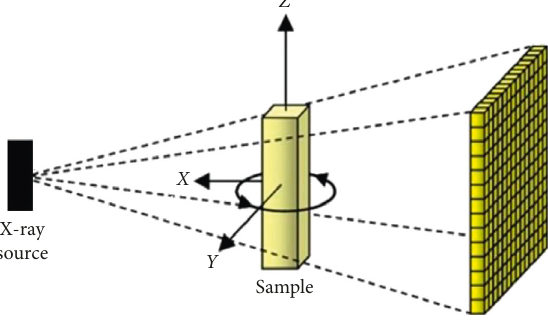
Figure 2: Principle of X-ray CT.